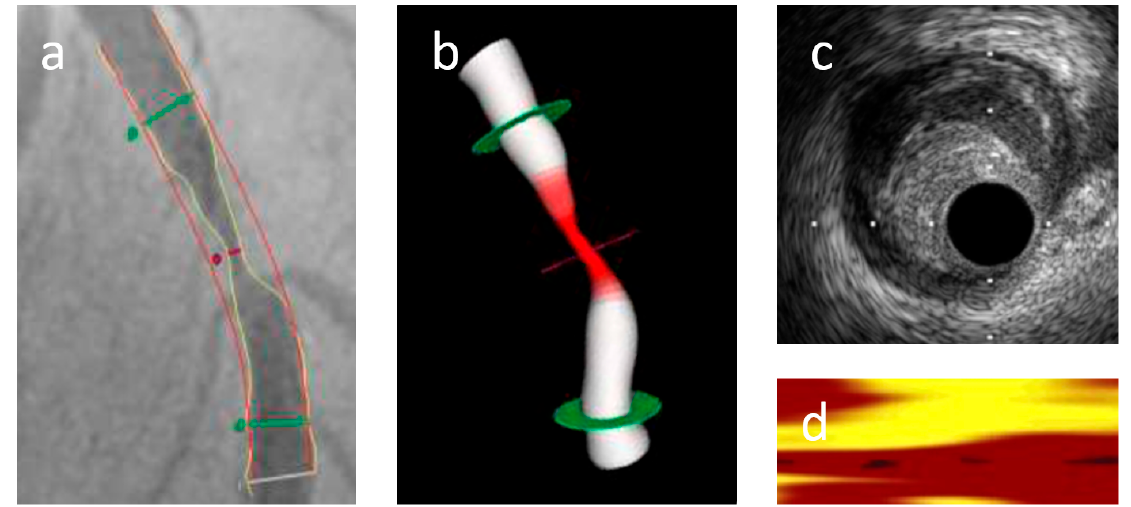
Figure 2. Representative of QFR-NIRS-IVUS imaging before stent implantation: ( a ) baseline angiography, ( b ) QFR, ( c ) IVUS and ( d ) NIRS analysis of a patient with stenosis of the LAD.